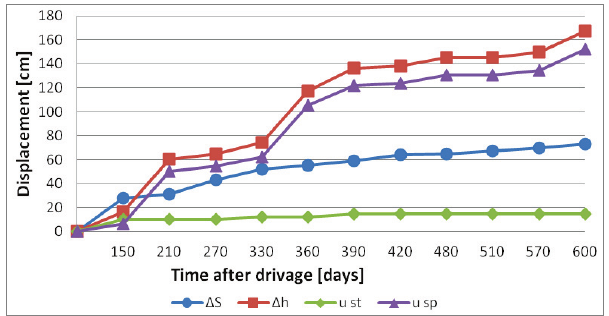
Fig. 5. Maingate D-2 convergence – base on 757 m (  S – roadway width change,  h – roadway height change, u st – roof displacement, u sp – floor heaving)